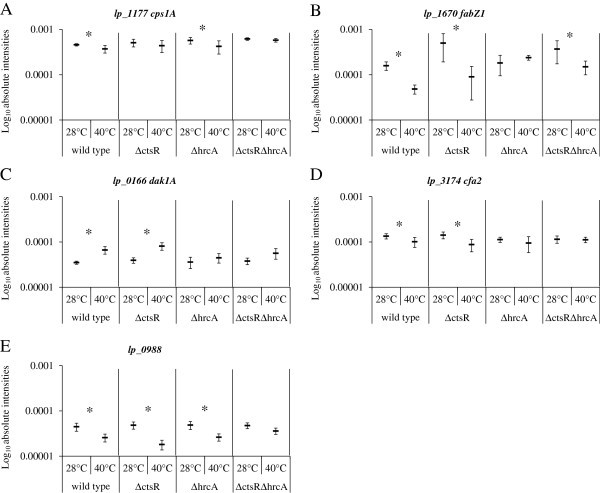
Box plots displaying the absolute intensity of the first gene of the cps cluster 1 (lp_1177; A), the fab-operon (lp_1670; B), dak1A (lp_0166; C), cfa2 (lp_3174; D), and lp_0988 (E) of L. plantarum WCFS1 (wild type), NZ3410 (ΔctsR), NZ3425CM (ΔhrcA), and NZ3423CM (ΔctsRΔhrcA) grown at 28°C or 40°C. Asterisk indicates that (part) of the loci are significant differentially expressed when compared to the strains growth at the other temperature.